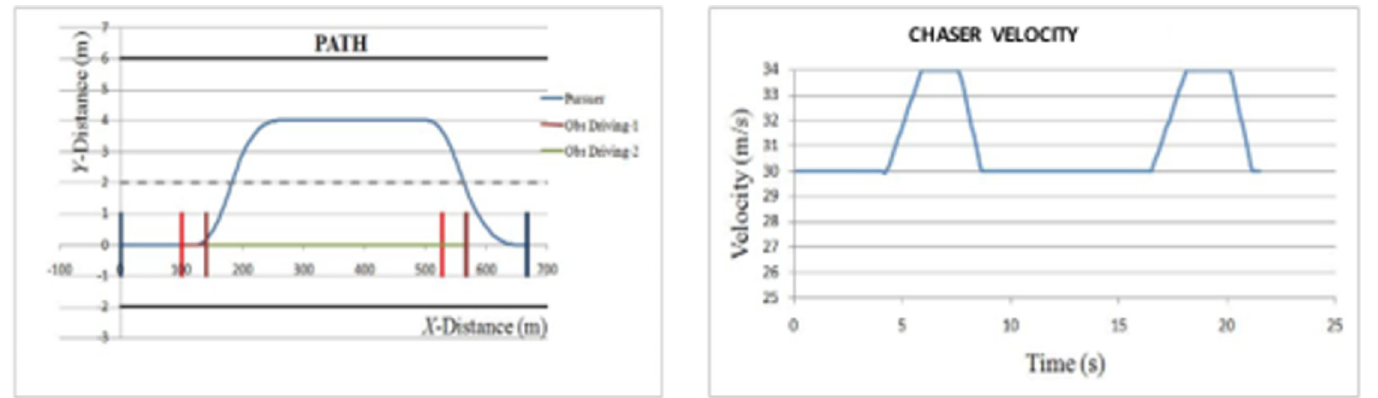
Fig 14. Profiling–velocity and path for C in scenario 4.